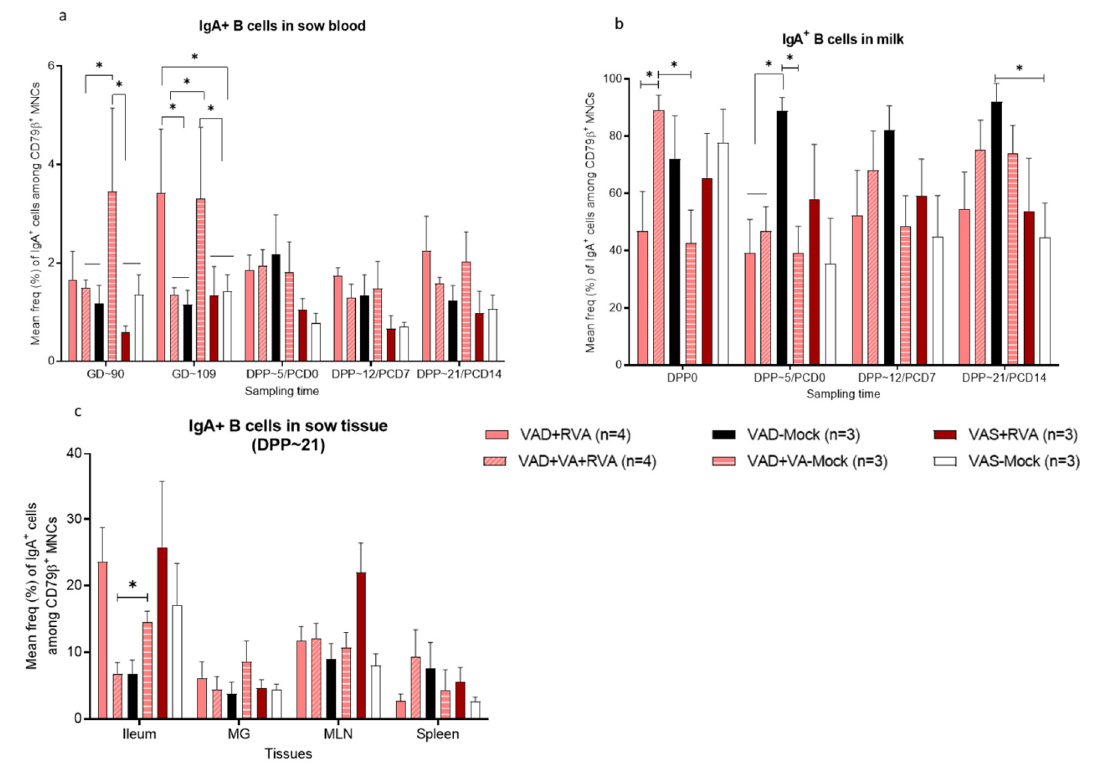
Figure 8. Mean frequencies (%) of IgA + B cell subpopulations among B lymphocytes (CD79 β + ) in blood ( a ), milk ( b ) and tissues (Ileum, MNL, spleen and MG) ( c ) of RVA (OSU)/mock inoculated sows fed VAS and VAD(±VA) diets during gestation and postpartum. (MLN, mesenteric lymph nodes; MG, mammary gland) (* p < 0.05).